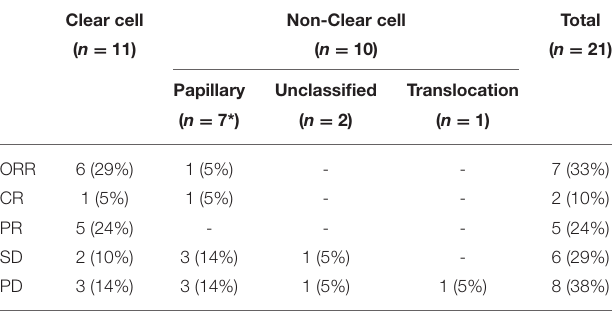
TABLE 2 | Best response rate by mRCC histology in patients with evaluable response ( n = 21 ). Clear